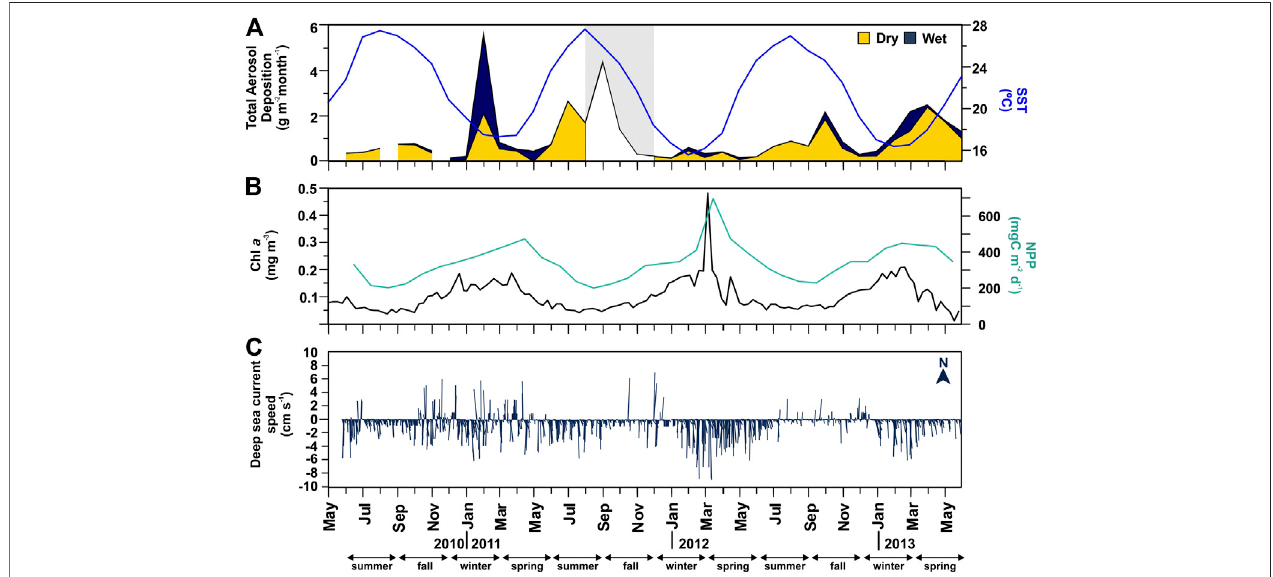
FIGURE 2 | Time-series of atmospheric and oceanographic parameters at the vicinities of the Ierapetra Basin station from June 2010 to June 2013. (A) monthly total aerosol [dry (yellow area) + wet (blue area)] deposition (in g m − 2 month − 1 ) at the Finokalia station*, and monthly Sea Surface Temperature (SST, in ° C, blue line); (B) 8-days surface Chlorophyll a concentration (Chl a , in mg m − 3 ), and monthly net primary production (NPP, in mg C m − 2 d − 1 , green line); and C) daily mean deep-sea currentspeed(incm s − 1 )anddirection( o )at4,287 mdepthintheIerapetraBasin(*grayareafromSeptembertoNovember2011indicatesvaluesareavailableonlyfor total atmospheric deposition, no distinction is made between dry and